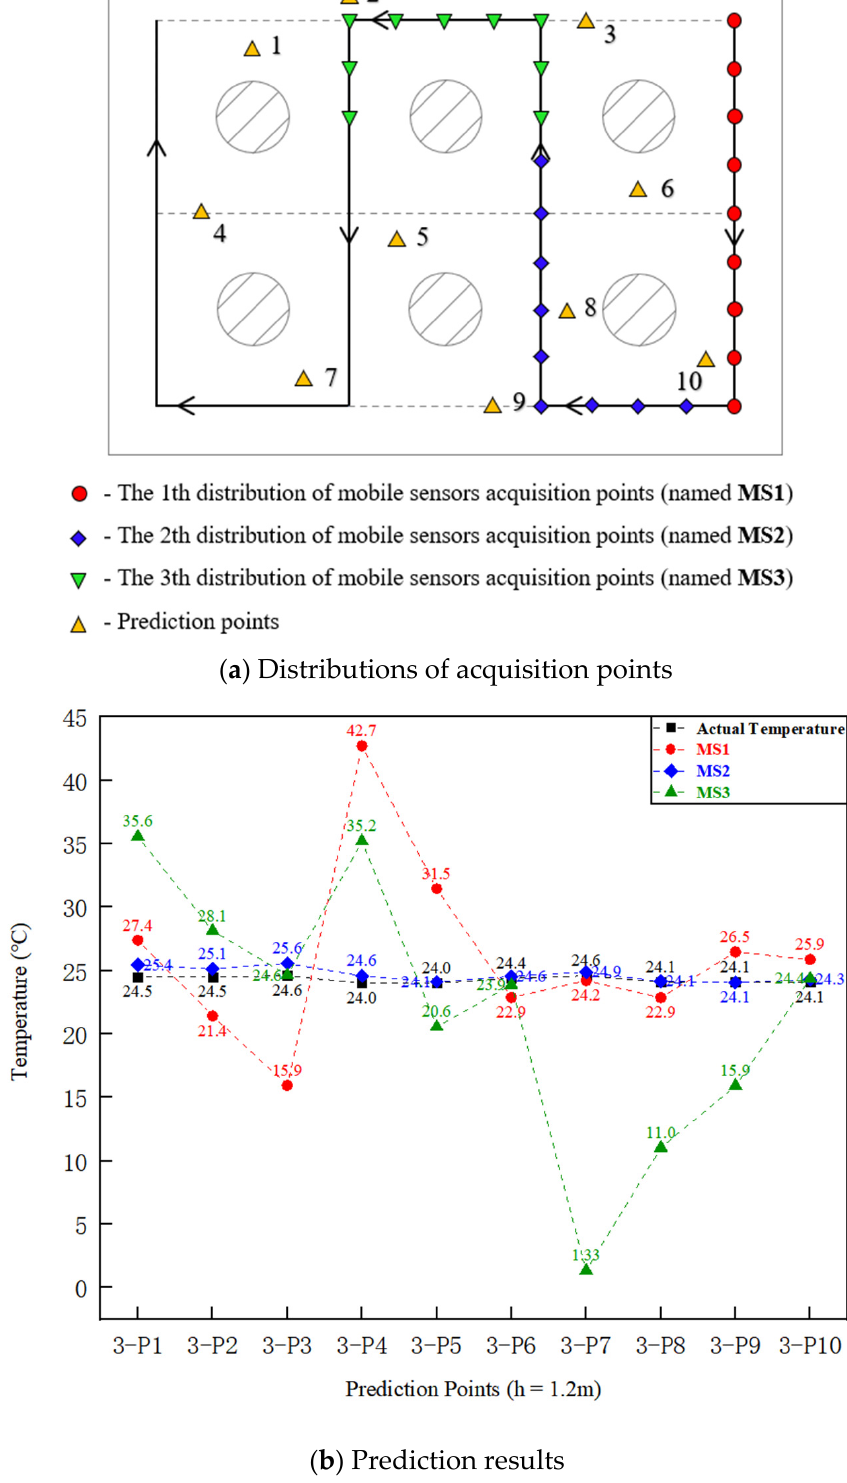
Figure 11. Prediction of mobile sensors with acquisition distance of 1.0 m.